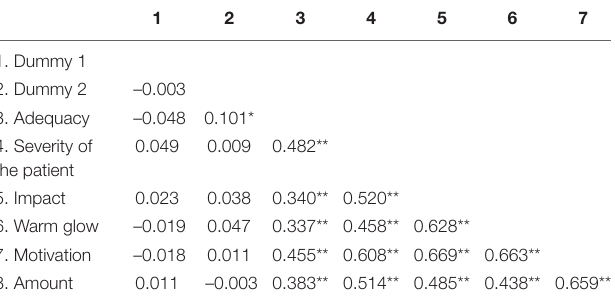
TABLE 1 | Correlation between amount of background information and main dependent